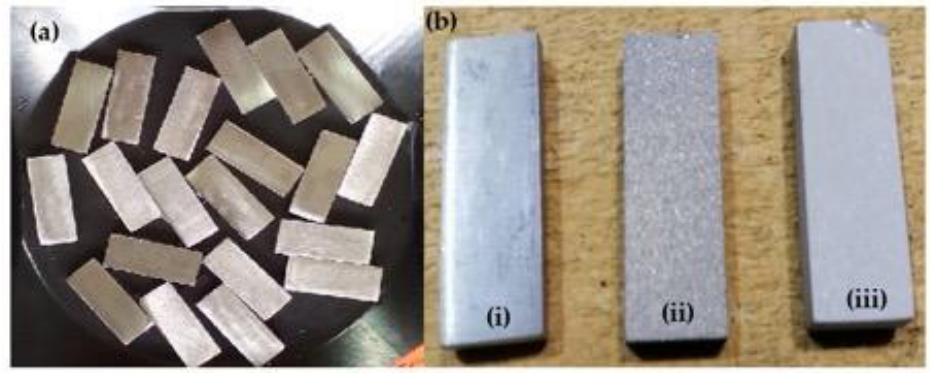
Figure 1. ( a ): Ti – 6Al – 4V alloy substrate; ( b ): ( i ) uncoated, ( ii ) grit-blasted, and ( iii ) plasma-coated. Figure 1. ( a ): Ti–6Al–4V alloy substrate; ( b ): ( i ) uncoated, ( ii ) grit-blasted, and ( iii )